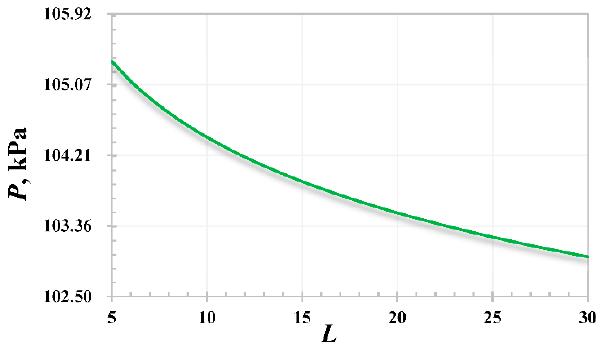
Figure 3. Effect of fracturing radius on CBM pressure.